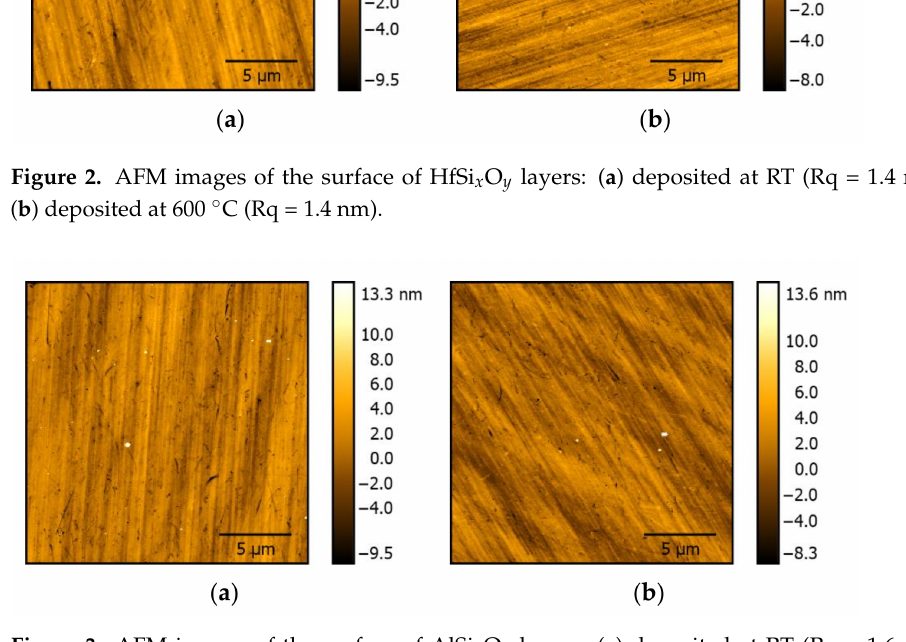
Figure 3. AFM images of the surface of AlSi x O y layers: ( a ) deposited at RT (Rq = 1.6 nm) and ( b ) deposited at 600 ◦ C (Rq = 1.9